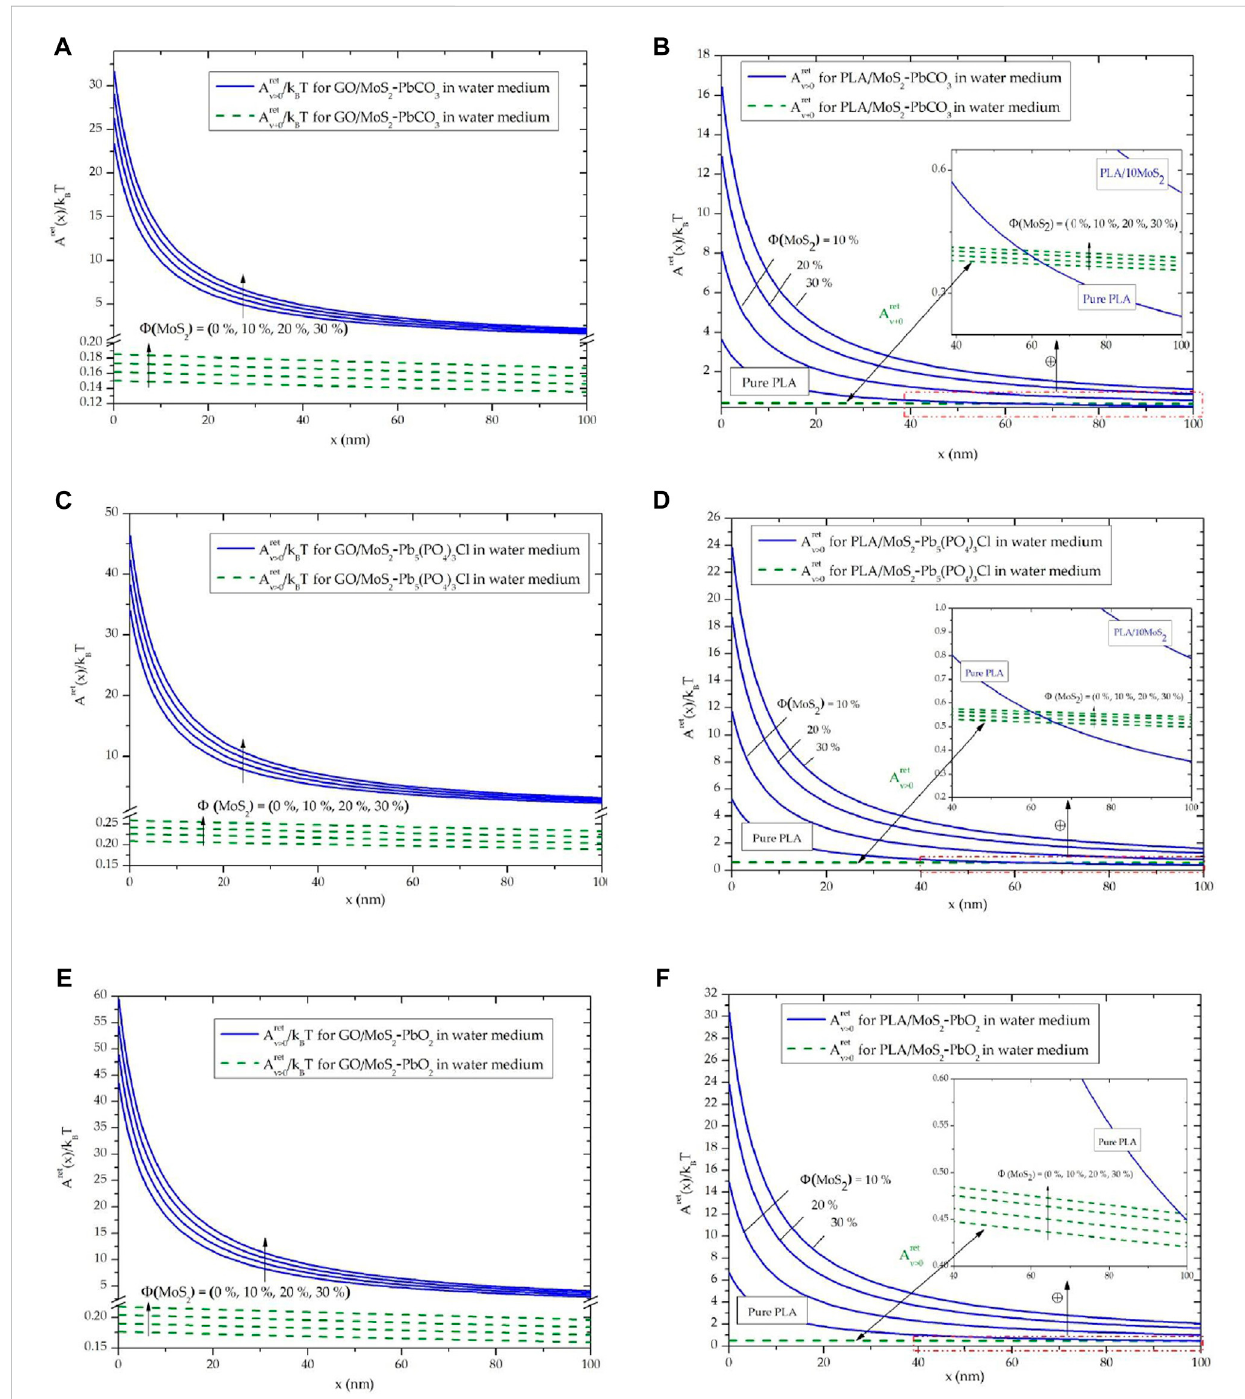
FIGURE 2 Evolution of the retarded Hamaker constant in a water medium between adsorbents and adsorbates: (A) GO/MoS 2 -PbCO 3 , (B) PLA/MoS 2 -PbCO 3 , (C)